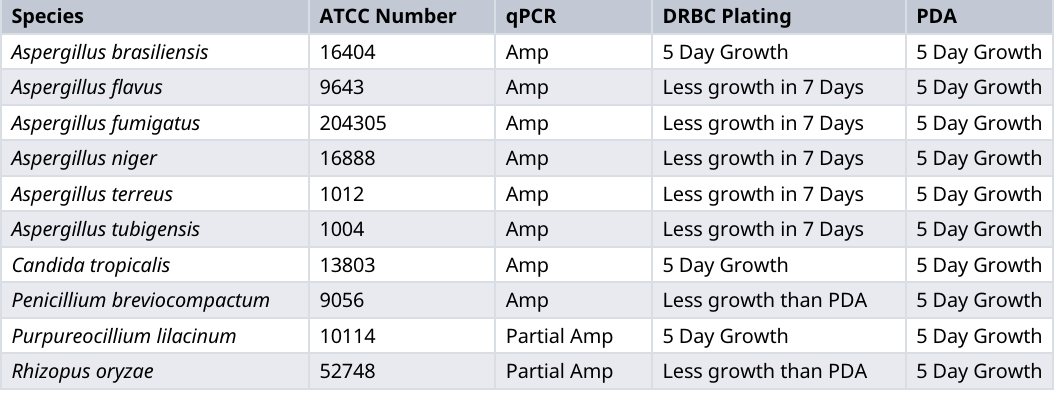
Table 3. Mono-culture evaluations. Fungi species were ordered from American Tissue Culture Collection (ATCC) and plated on 2 different medias (PDA and DRBC) to assess growth performance of the organisms in absence of cannabis background bacteria and matrix.